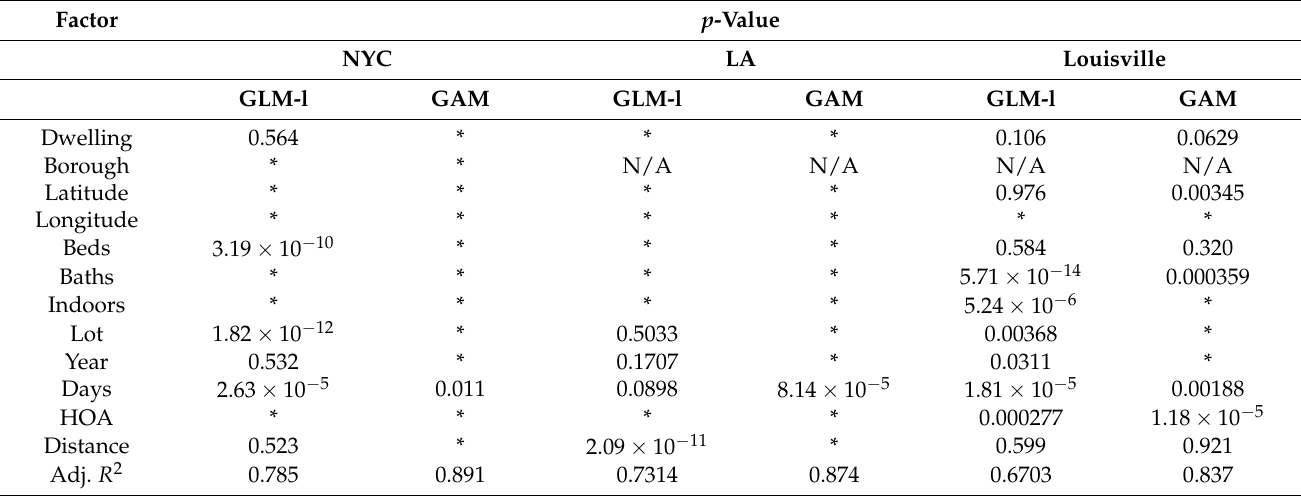
Table 2. Significance ( p -value) of the factors in the GLM-l and GAM pricing